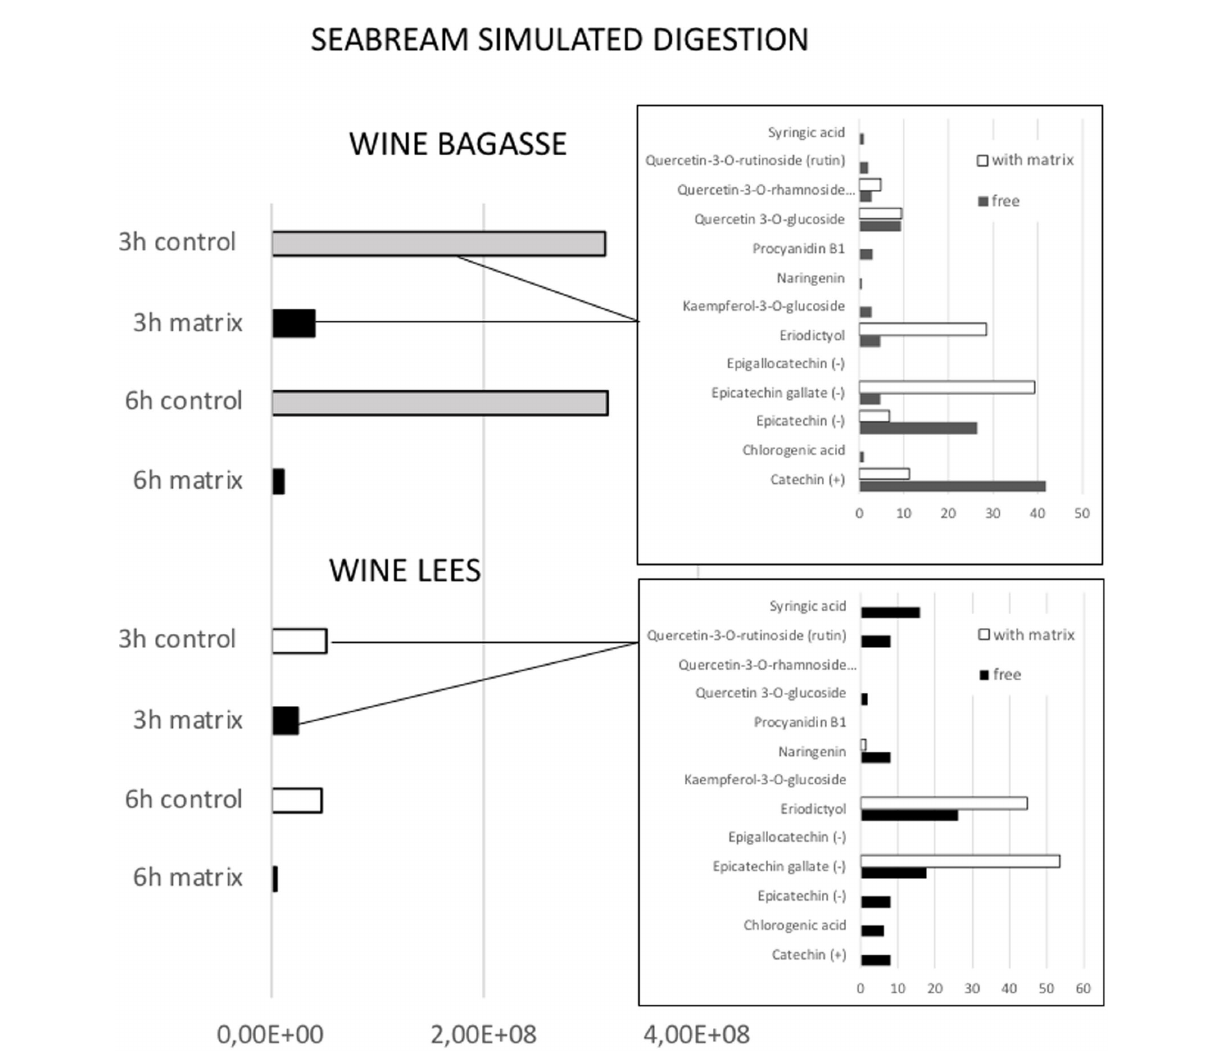
FIGURE 4 Effect of feed matrix on the release of total phenolic compounds from either wine bagasse or lees, measured at two different digestion times (3 and 6 h) during simulated digestion of seabream. Values are expressed as the sum of all peak areas detected in samples measured by UHPLC. The release of specific types of phenolics after 3 h digestion of either bagasse or lees are shown in the small graphs, being values expressed as % of the total amount of phenolics measured in the presence or absence of feed